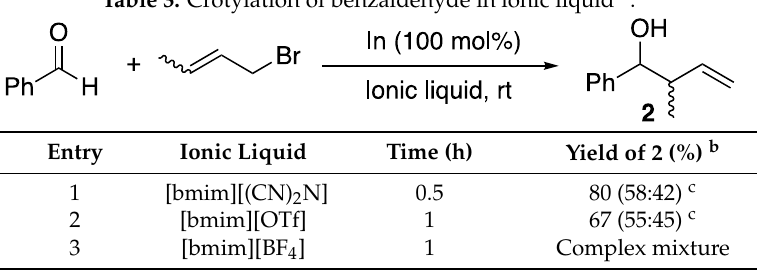
Table 3. Crotylation of benzaldehyde in ionic liquid a .